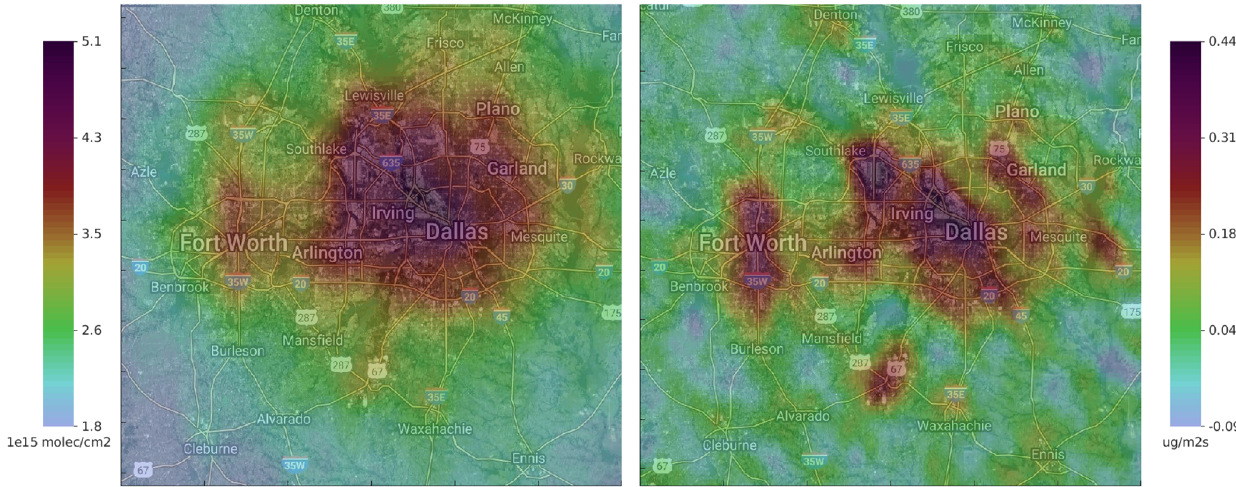
Figure 9. Oversampled TROPOMI NO 2 in the Dallas–Fort Worth metropolitan areas using the (left panel) tropospheric vertical columns and (right panel) the flux divergence of the tropospheric vertical columns. The underlaid image is from © Google Earth.